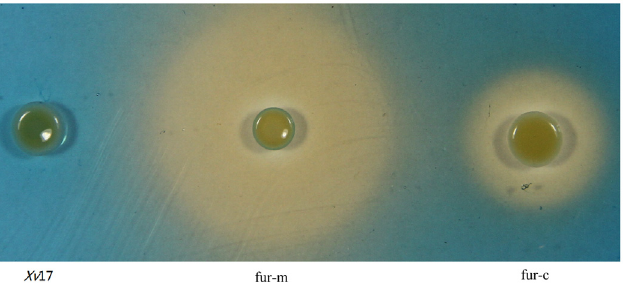
Fig 1. Comparison of siderophore production in Xv strains using the Chrome azurol S assay. Yellow halos around bacterial colonies indicate siderophore production. Xv 17: wild-type Xv strain; fur-m: fur mutation strain of Xv 17; and fur-c: fur complementation strain of fur-m.